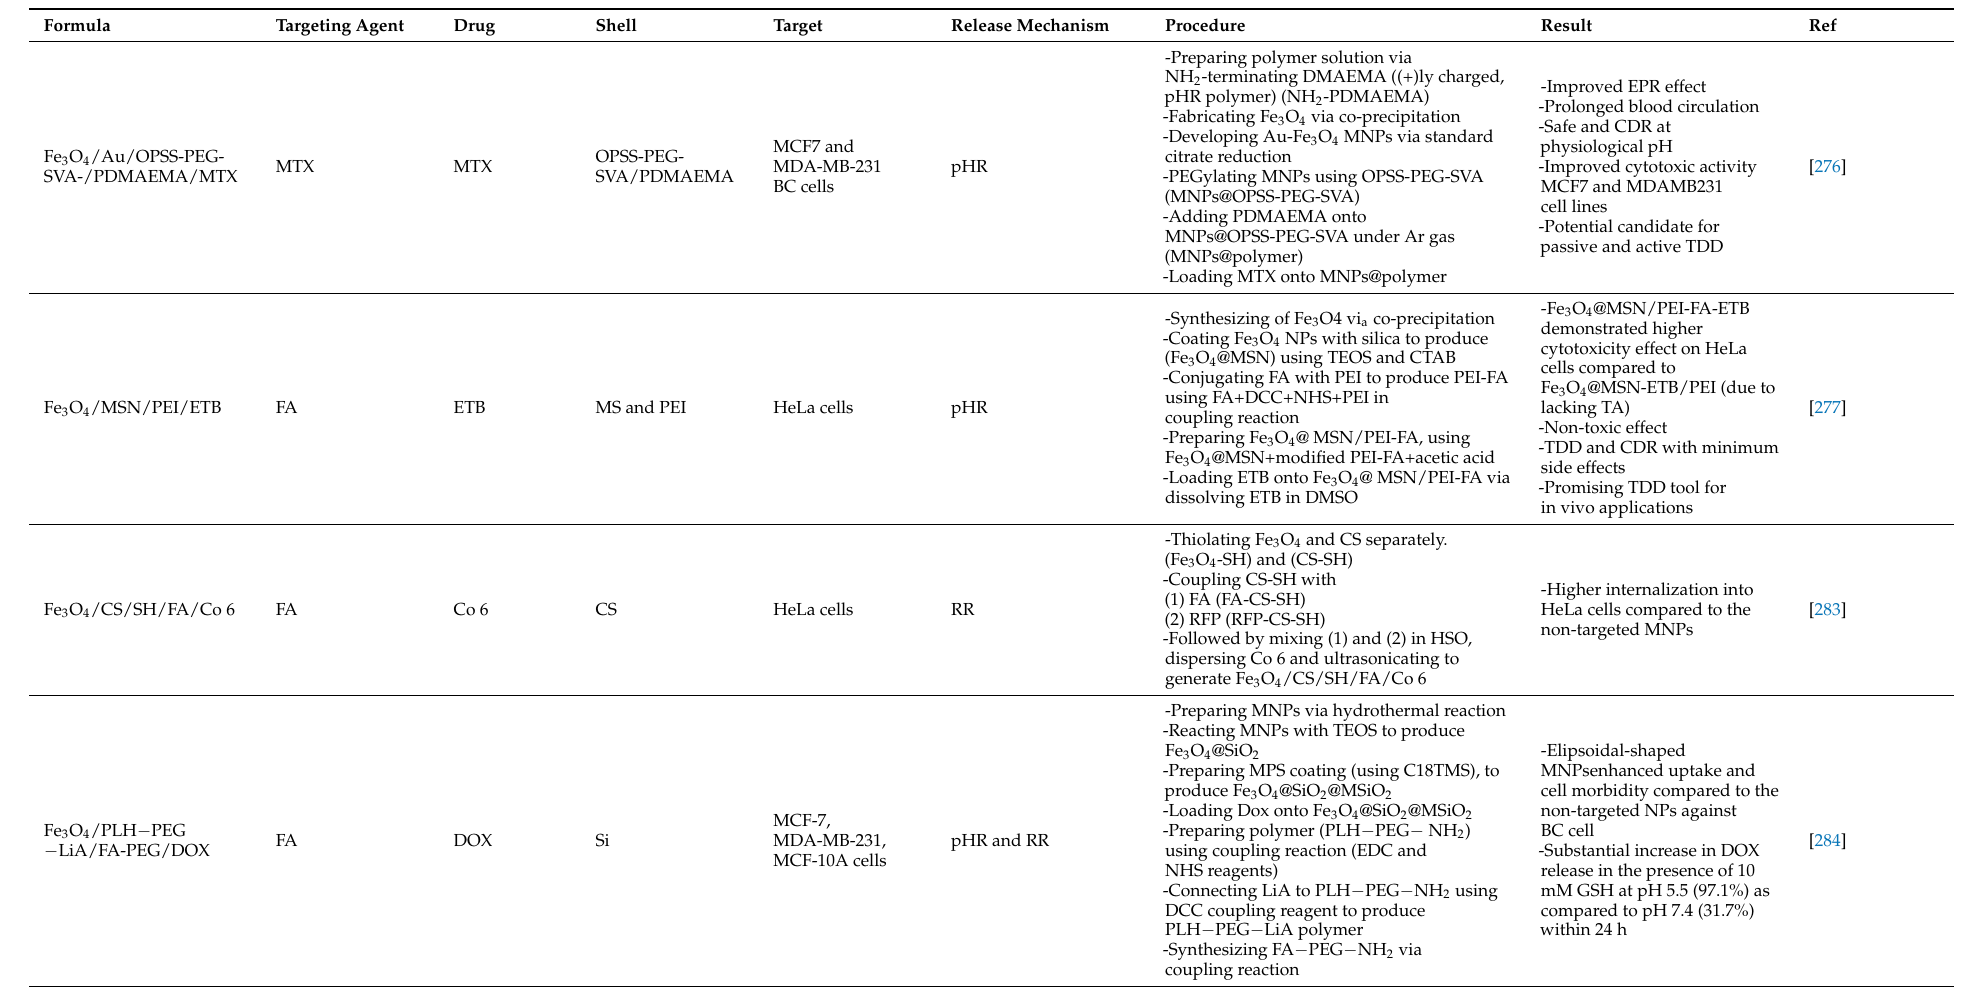
Table 11. Examples of Active Targeted Drug Delivery of SIONPs for cancer